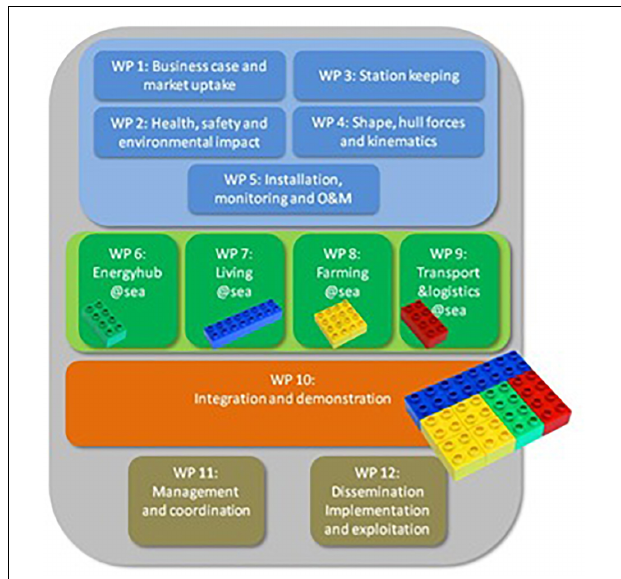
FIGURE 3 | Space@Sea project structure.